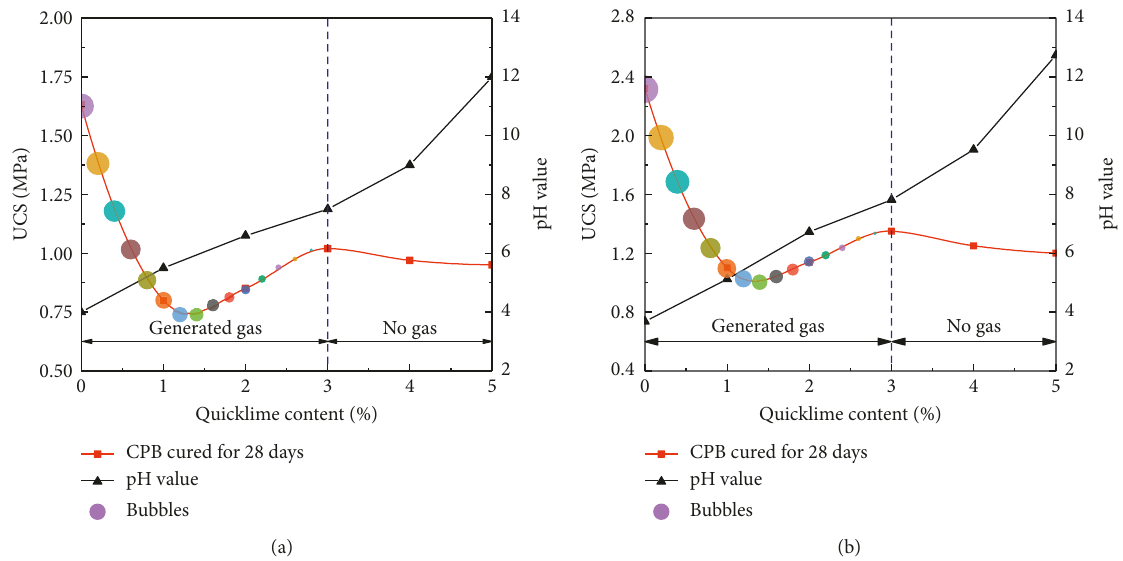
F IGURE 4: Effects of quicklime content on the bubbles and UCS of CPB. (a) HPG/PS ratio of 4 and mass fraction of 66%; (b) HPG/PS ratio of 6 and mass fraction of 66%.